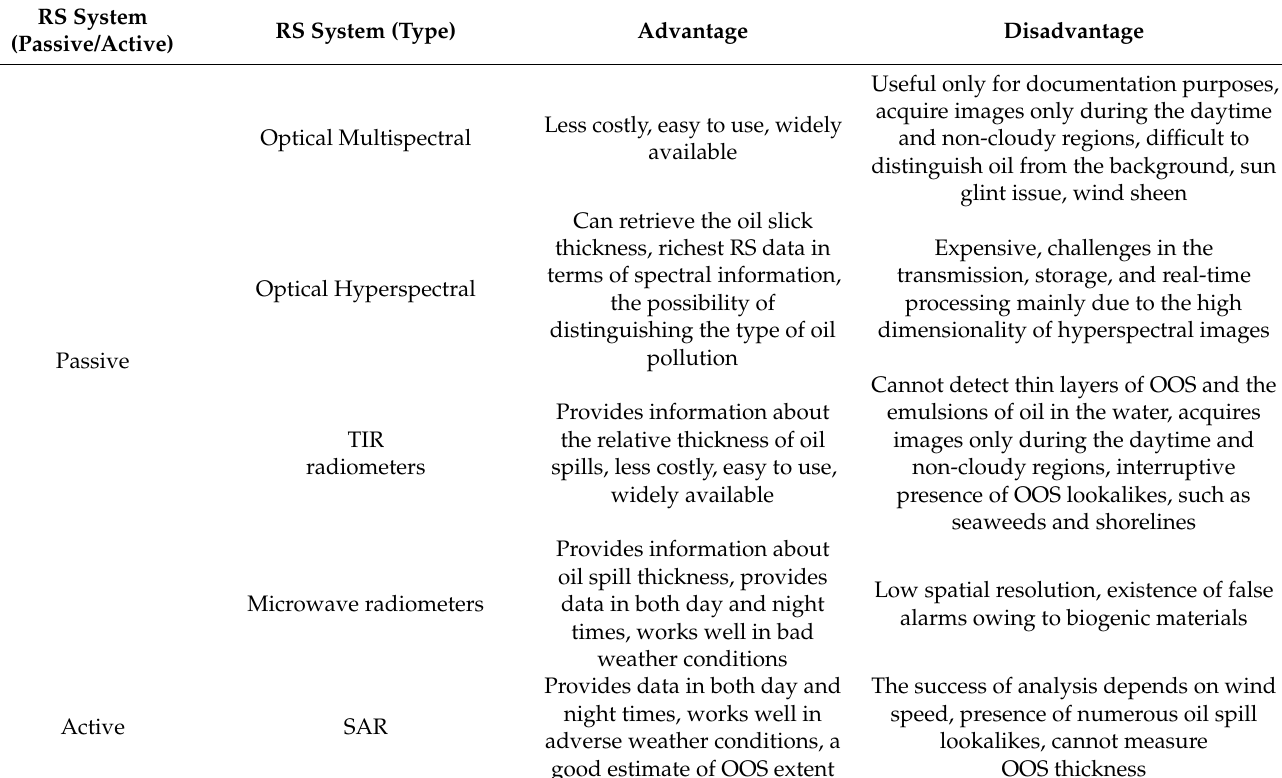
Table 5. Different RS systems for OOS detection along with their advantages and